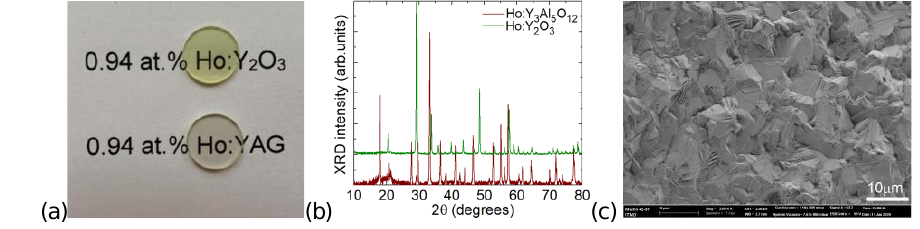
Fig. 1 (a) Photograph of the laser-grade polished ceramic disks; (b) X-ray powder diffraction (XRD) patterns of ceramics; (c) Scanning Electron Microscope (SEM) image of the fracture surface of the Ho:Y 2 O 3 ceramics.